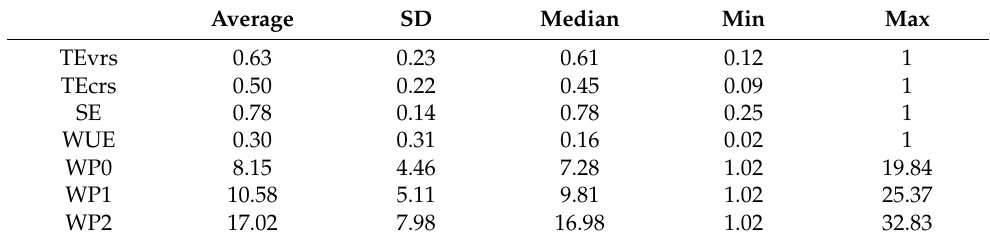
Table 4. Descriptive statistics of TE, SE, WUE, and WP.